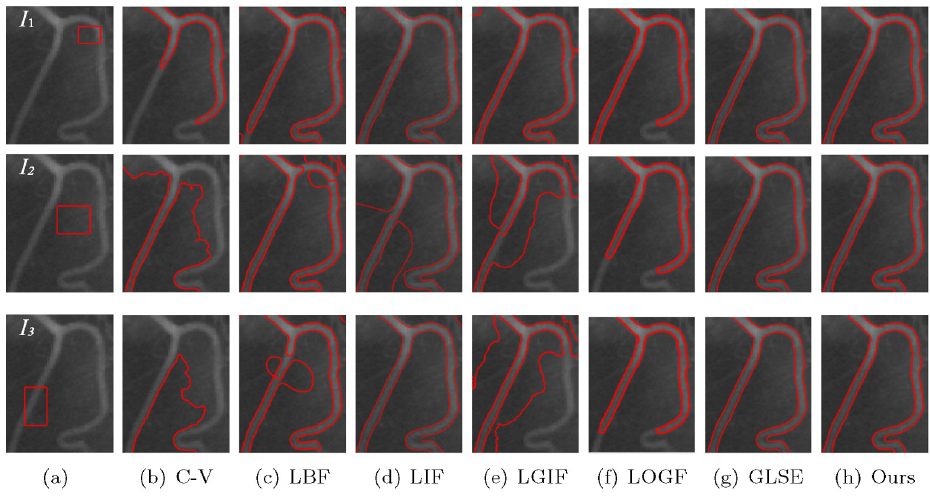
Fig 7. Comparisons for a vessel image with variying initial contours.